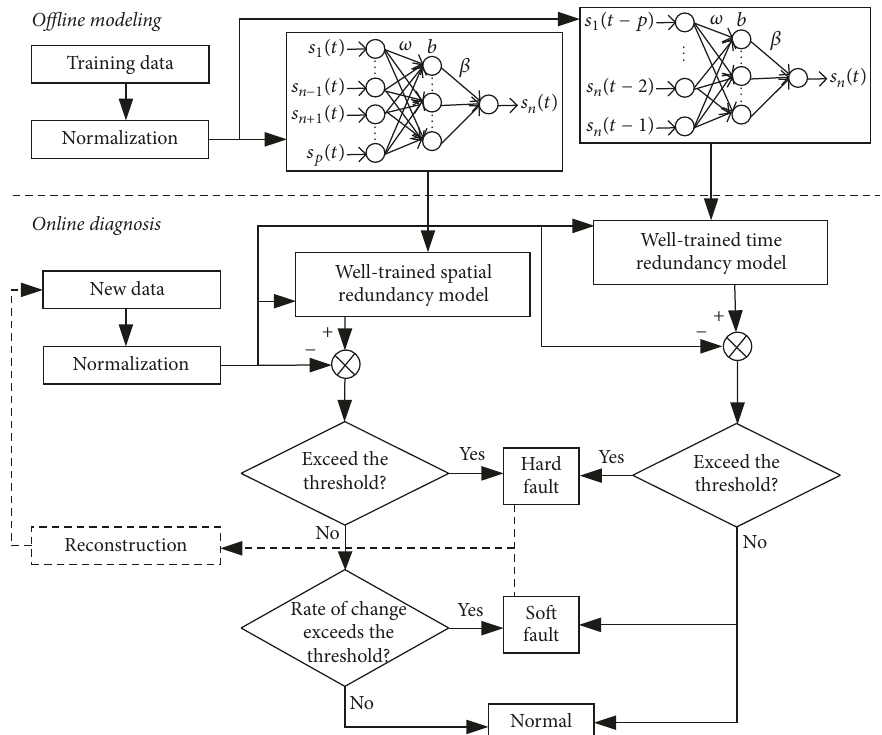
Figure 1: WOS-ELM-based double redundancy FDR method.